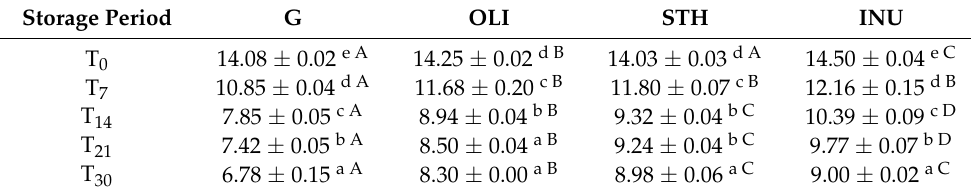
Table 4. Viability of lactobacilli strains during the storage period. Storage